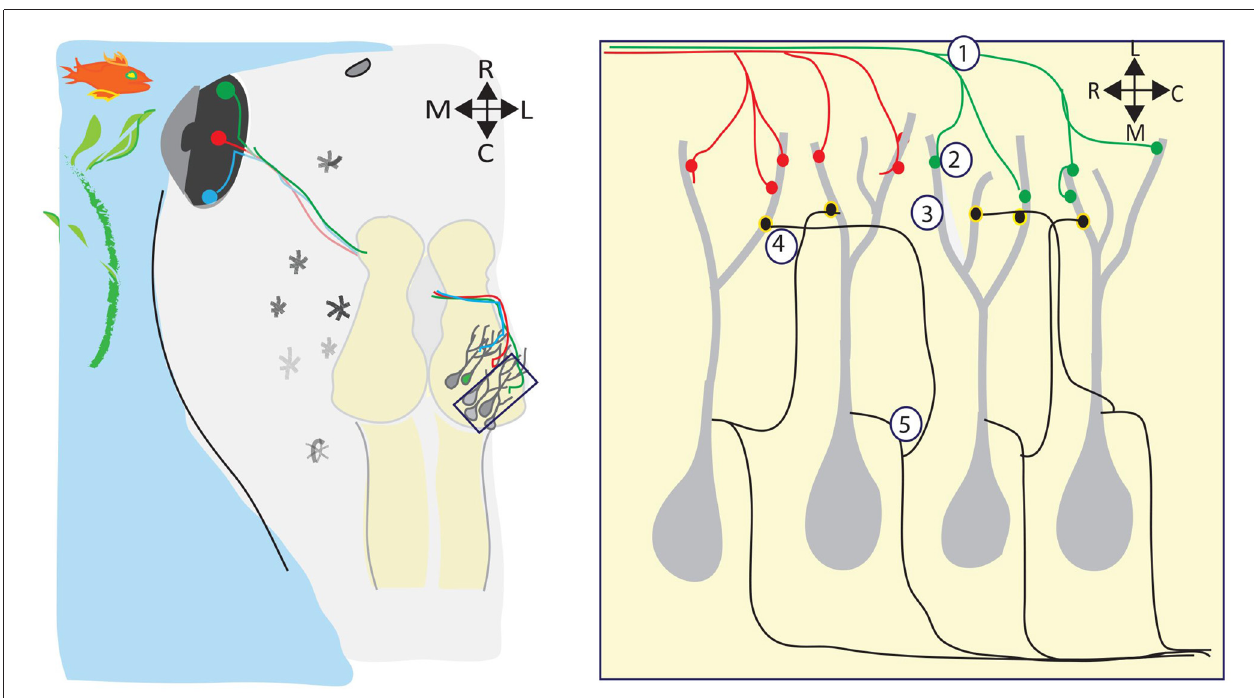
FIGURE 2 | Visual experience regulates many aspects of retinotectal circuit development. (Left) The retinotectal circuit is comprised of the RGCs in the eye which project their axons to the optic tectum, the primary visual processing area in tadpoles and frogs. Retinotectal axons extend in the optic tract across the ventral midline of the brain, and then extend dorsally and caudally to their final destination, the contralateral optic tectum. Here, RGC axons branch out and form synapses with postsynaptic tectal neurons, forming a topographic map of visual space within the tectal neuropil such that near-neighbor RGCs synapse with near-neighbor tectal neurons. Visual stimuli in the tadpole’s environment activate the RGCs. During retinotectal circuit development, this visually-driven activity refines the retinotopic map (1), drives the development and maturation of the complex postsynaptic tectal neuron dendritic arbors (2), regulates the maturation and stabilization of retinotectal synapses (3), refines the microcircuitry within the tectum (4), and sets the level of intrinsic excitability expressed by tectal neurons